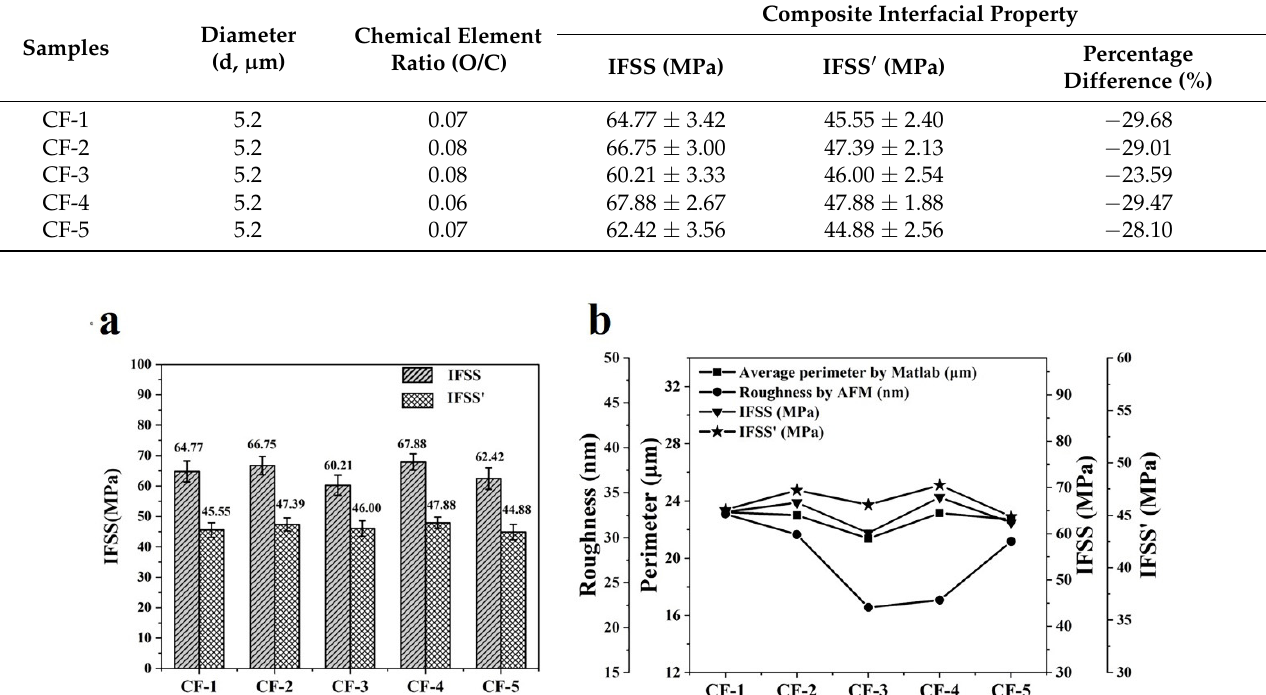
Figure 10. ( a ) IFSS and IFSS’ of CF composites and ( b ) the relationship between composite interfacial property, cross-section perimeter and surface roughness of CFs.